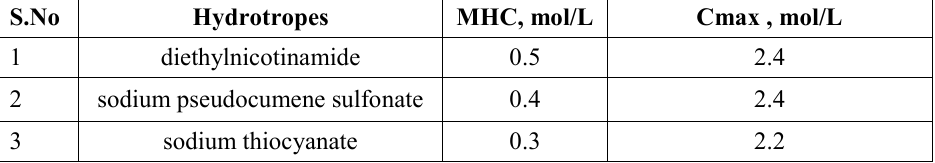
values of hydrotropes. max